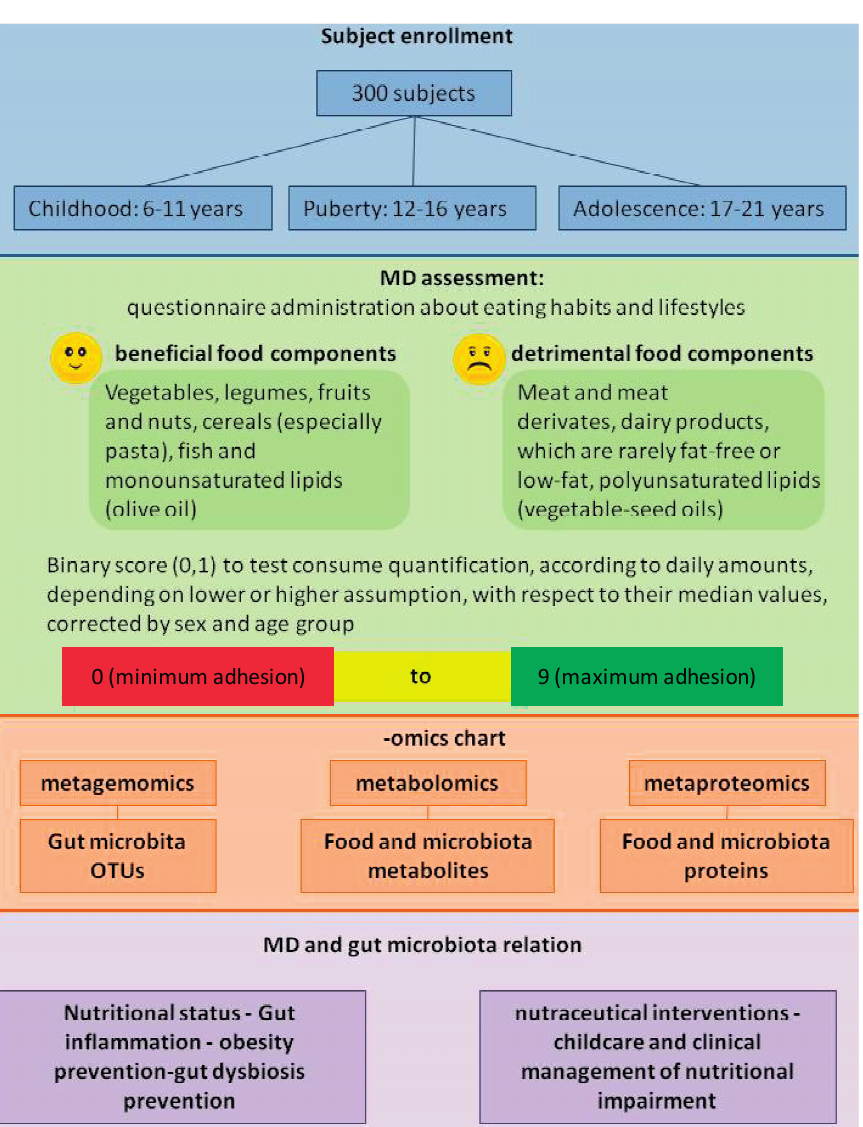
Figure 3. MD and gut microbiota relationship: A proposal for a study